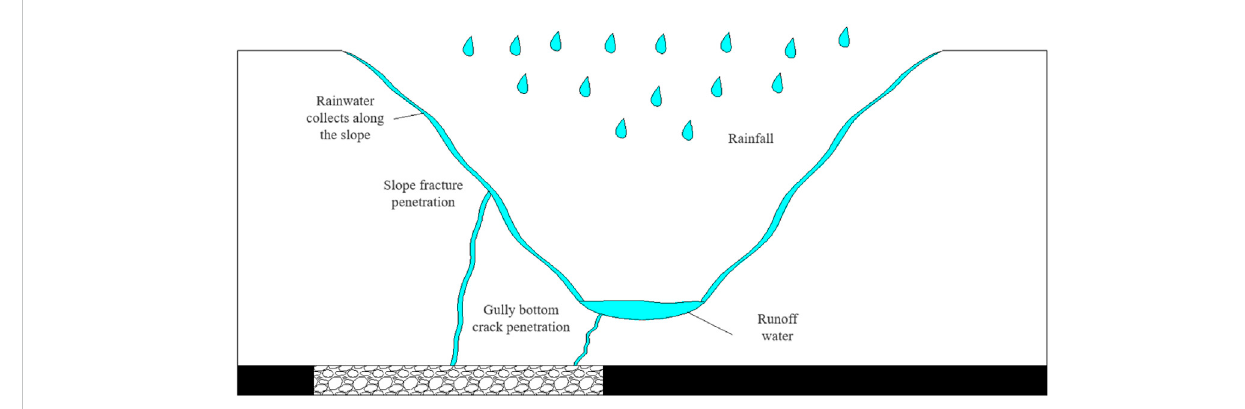
FIGURE 2 Schematic diagram of connection between valley seasonal runoff and mining-induced